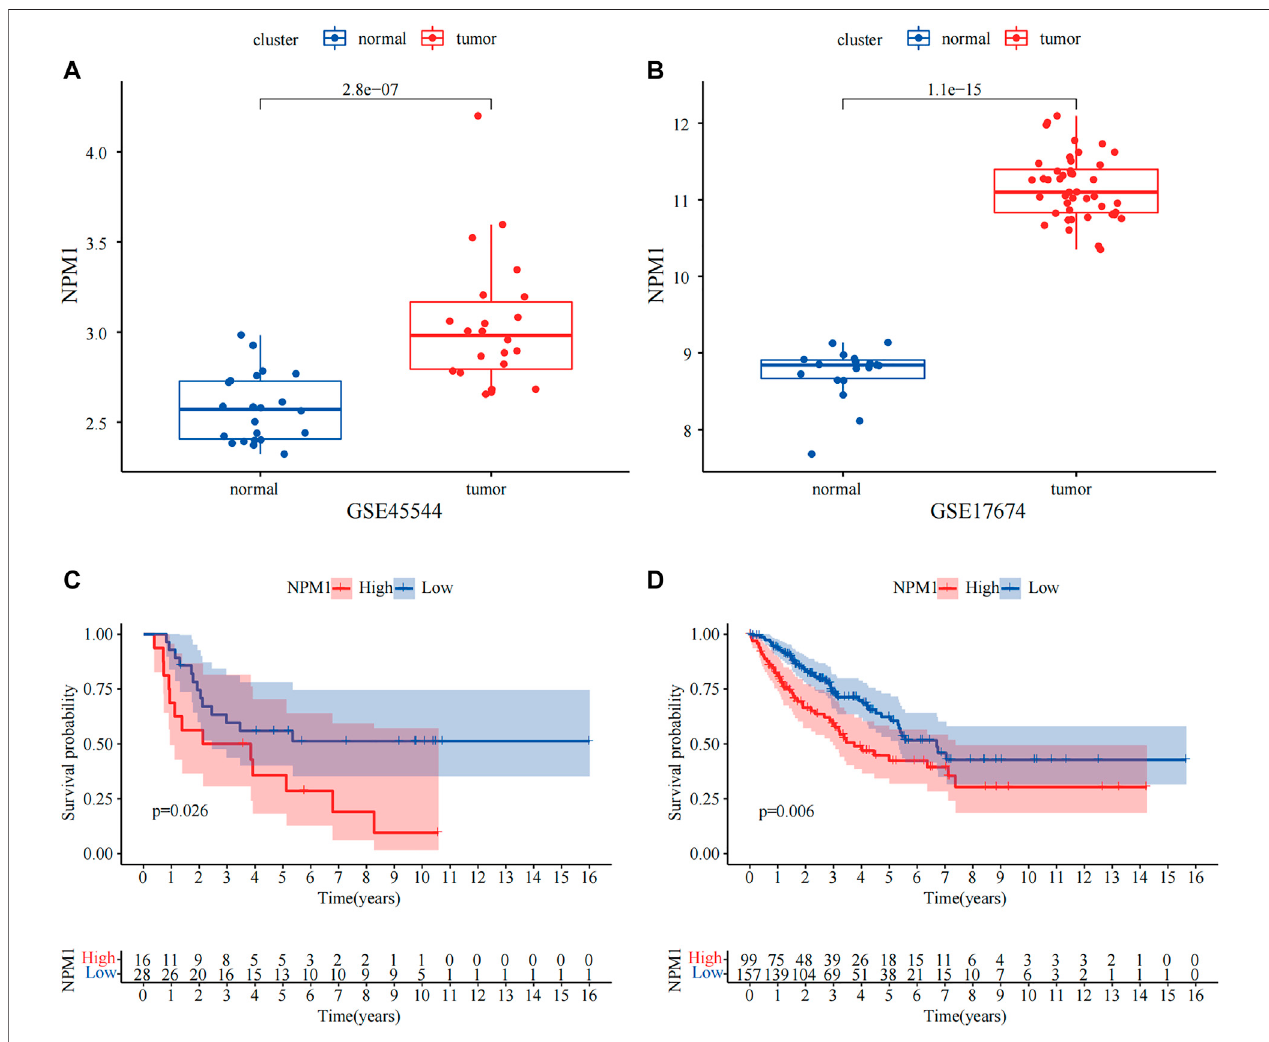
FIGURE 9 | External dataset validation of the variability of NPM1 and correlation with survival. (A,B) In GSE17674 and GSE45544, NPM1 was highly expressed in ES groups. (C,D) Gene Expression Omnibus (GEO) and The Cancer Genome Atlas (TCGA) data demonstrate that high NPM1 expression is strongly associated with poor